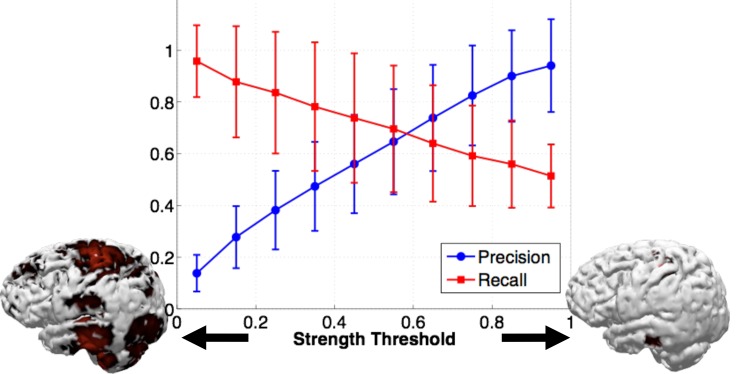
An example of Precision (blue) and Recall (red) plotted against strength threshold, for the sLORETA algorithm and 2 simulated sources.The picture of the cortex on the left indicates what imposing a low (5%) strength threshold on the CSD result looks like, with widespread activity. The cortex on the right indicates what imposing a high strength threshold (95%) looks like, with sparse activity.